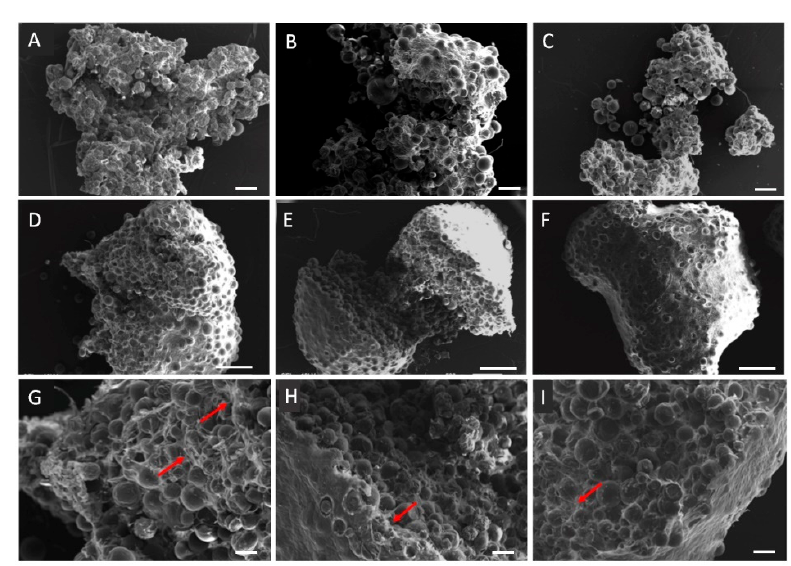
Figure A1. MT SEM images from ( A – C ) U96 well-plates with 25,000 cells/mg MC, 12,500 cells/mg MC two-step seeding and 50,000 cells/mg MC, scale bars = 200 µ m; ( D – F ) 24 well-plates with 25,000 cells/mg MC, 12,500 cells/mg MC two-step seeding and 50,000 cells/mg MC, scale bars = 500 µ m; and ( G – I ) transversal sections from 24 well-plates MTs with 25,000 cells/mg MC, 12,500 cells/mg MC two-step seeding and 50,000 cells/mg MC, scale bars = 100 µ m. Arrowheads pointing fibrillar ECM.